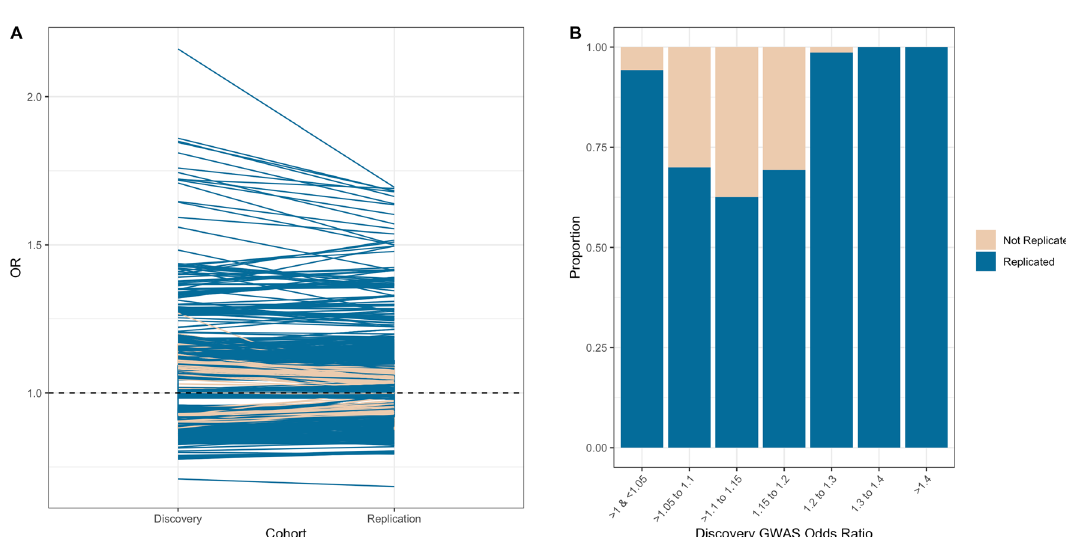
Figure 3. Replication of SNVs across odds